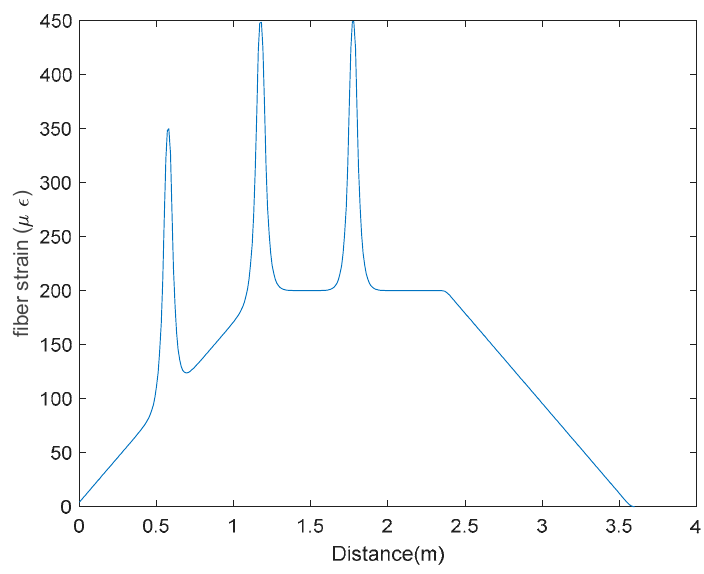
= 0.02 mm and γ = 40 m − 1 ).